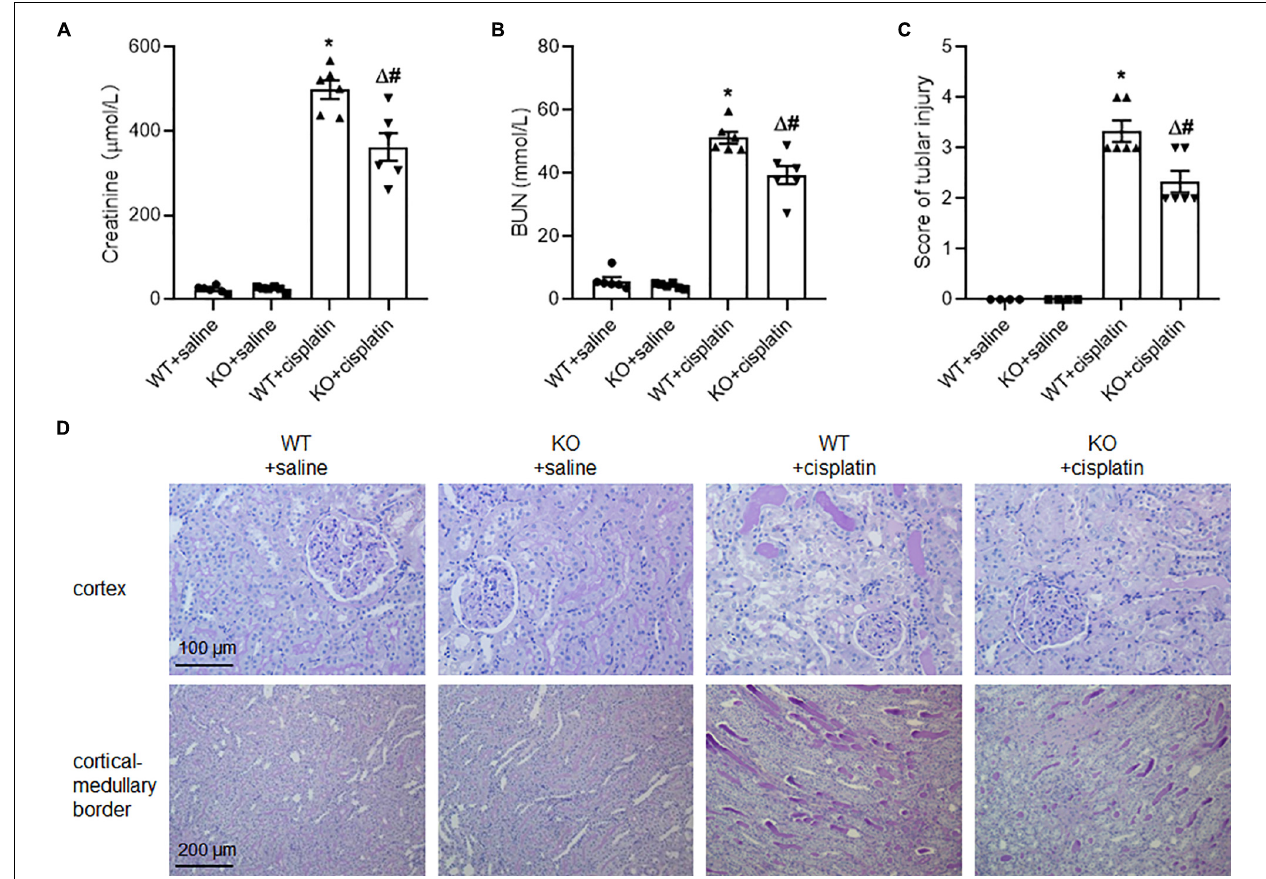
FIGURE 1 | PINK1 deficiency attenuated cisplatin-induced acute kidney injury. PINK1 KO and WT rats were injected with 5 mg/kg cisplatin or saline for 72 h. (A) Plasma level of BUN in PINK1 WT and KO rats after cisplatin treatment. (B) Plasma level of creatinine in PINK1 WT and KO rats after cisplatin treatment. (C) Pathological score of tubular damage. (D) Representative histology of kidney cortex by PAS staining. N = 6 in each group. ∗ P < 0.05, WT + cisplatin vs. WT + saline; # P < 0.05, KO + cisplatin vs. WT + cisplatin; (cid:49) P < 0.05, KO + cisplatin vs. KO + saline. Data are mean ±